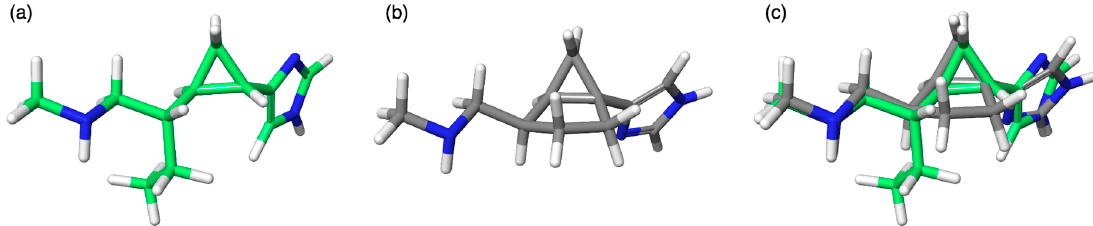
Figure 6. The most stable conformation of 5 ( a ) and 7 ( b ) by conformational search using MacroModel 10.9. (force field: MMFFs, solvent: H 2 O); ( c ) Superimposition of the stable conformation of 5 and 7 . The chlorobenzyl moiety was replaced with a methyl group to simplify the structures.